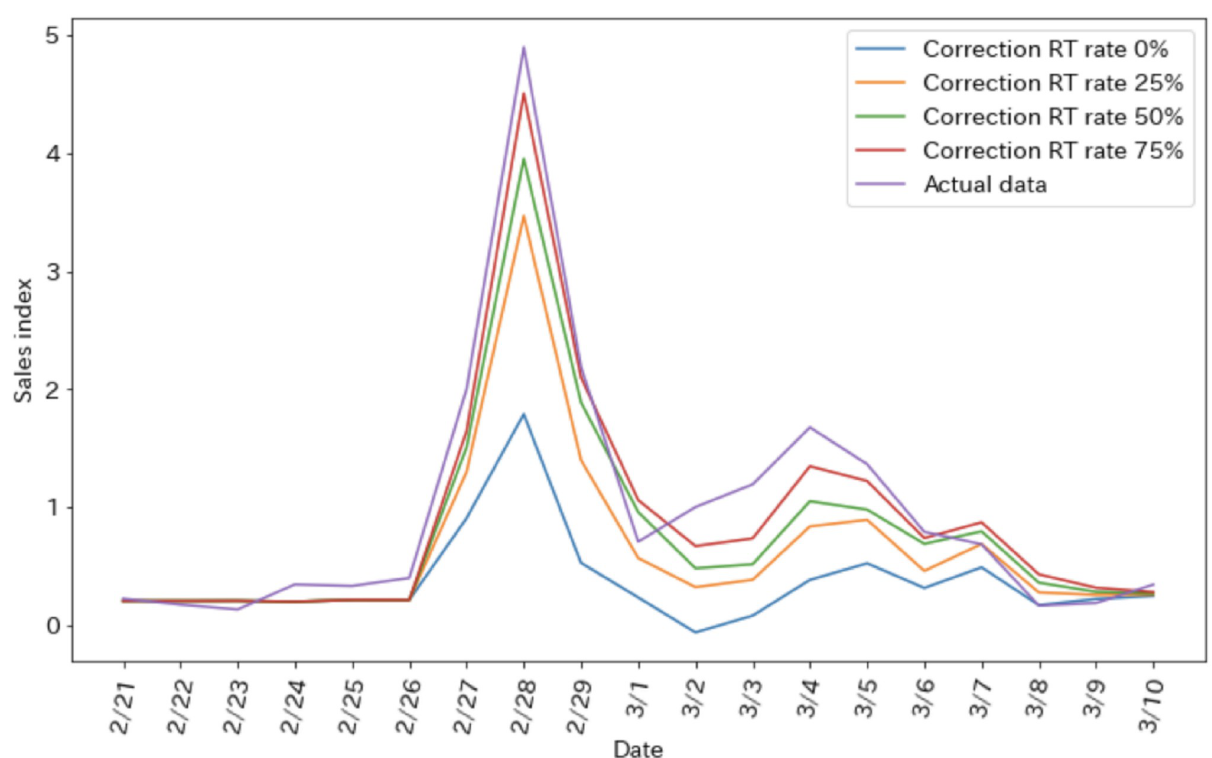
Fig 5. Results of